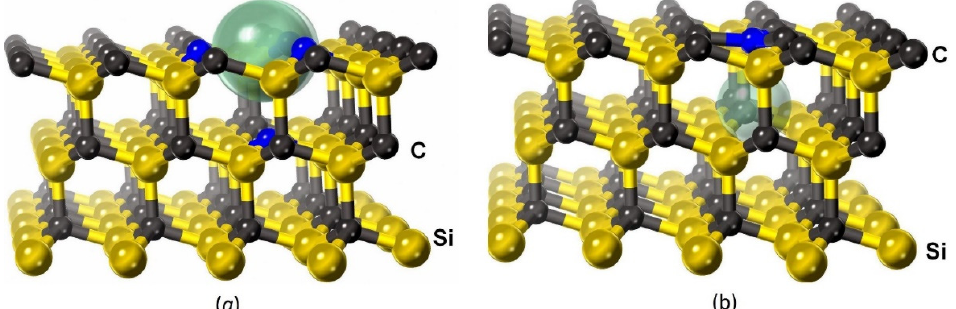
Figure 6. 3C–SiC with the silicon vacancy V Si ( a ) or C 4 V center formed by a leap of the C atom from the bottom upward to the place of the vacancy ( b ). Semitransparent spheres denote voids; blue color marks C atoms having dangling bonds and a magnetic moment.